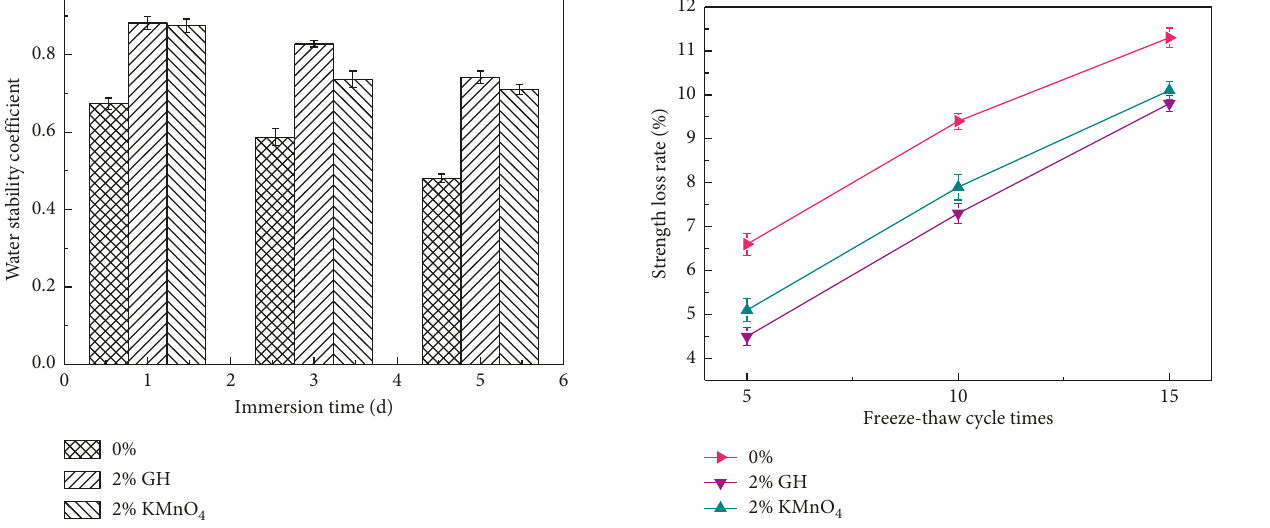
Figure 3: The water stability coefficient of the dredged sludge solidified